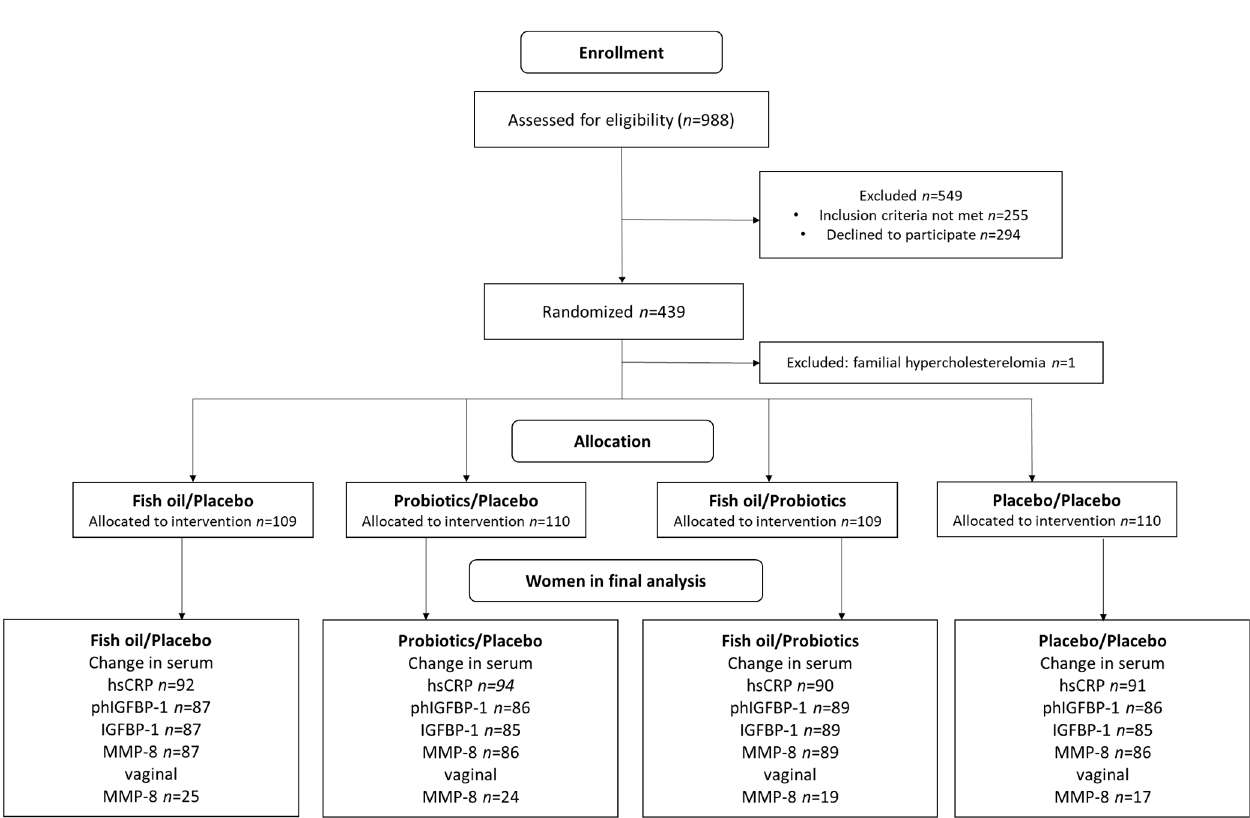
Figure 1. Flow chart. hsCRP, high-sensitivity C-reactive protein; phIGFBP-1, phosphorylated insulin-like growth factor binding-protein 1; MMP-8, matrix metalloproteinase 8.